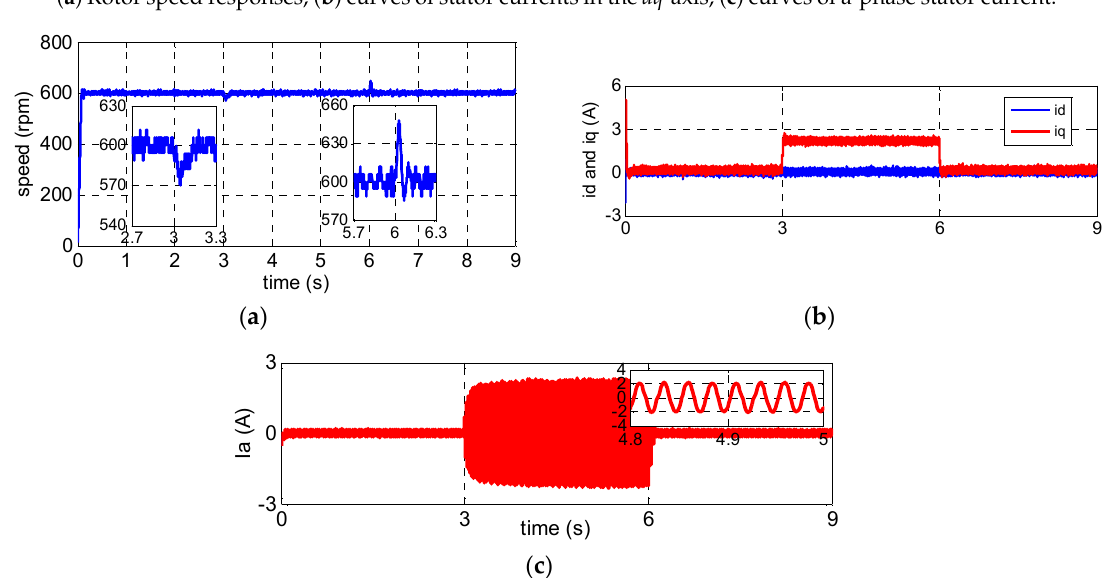
Figure 18. Experimental curves of rotor speed with a step disturbance of 1 N ∙ m under the DMPC+ESMO method: ( a ) Rotor speed responses; ( b ) curves of stator currents in the dq -axis; ( c ) curves of a-phase stator current.